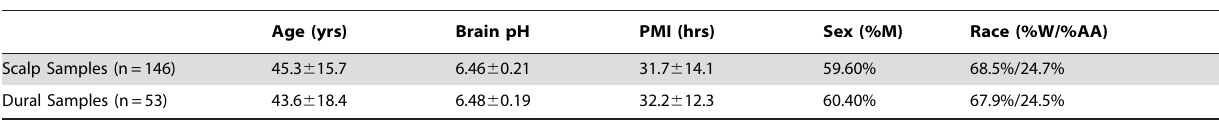
Table 3. Sample Demographics.